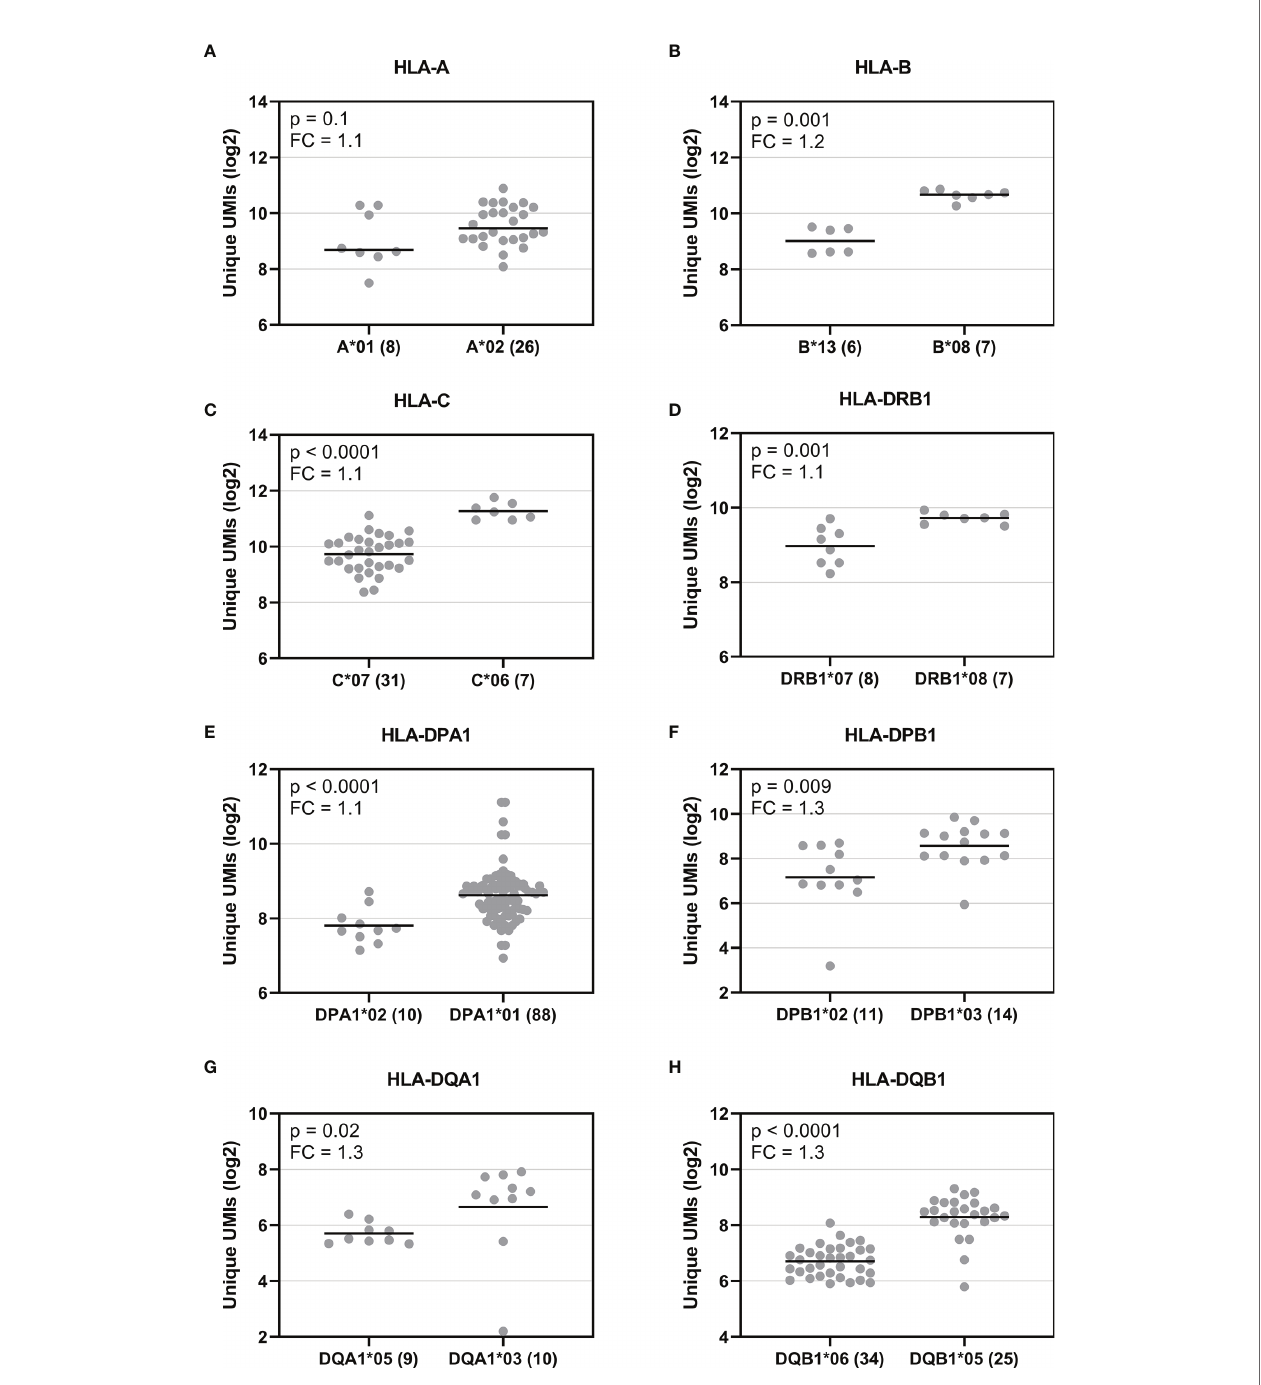
FIGURE 5 | Comparison of the mRNA expression between the highest and lowest expressed allelic lineage of eight HLA genes. Y-axis indicates the normalized UMIs (Log2) of cDNA data and X-axis indicates the names of the selected allelic lineages of eight HLA genes (A – H) . Each dot indicates a UMI value and a solid bar indicates the median expression of the lineage. The number inside the parenthesis indicates the number of samples. The expression between the allelic lineages was compared using a Mann-Whitney U